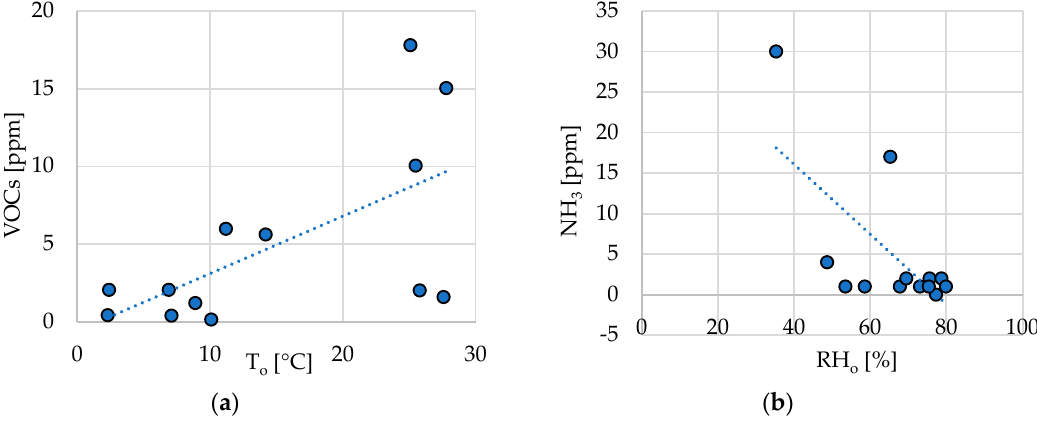
Figure 11. Correlation diagrams between odorant concentration in the pre-RDF storage section of biogas plant B and measured microclimatic parameters, with regression lines: ( a ) R 2 = 0.39, ( b ) R 2 = 0.44.